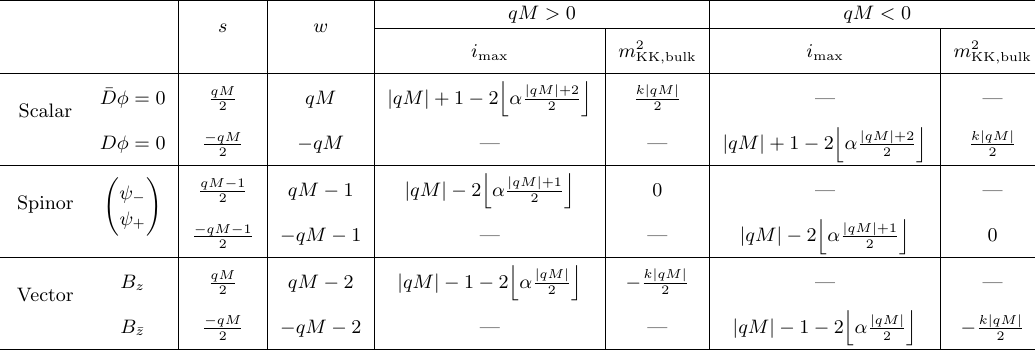
Table 2 . Possible combinations of the weights s and w , the degeneracy i max and the square of the lowest bulk KK mass spectrum for normalizable